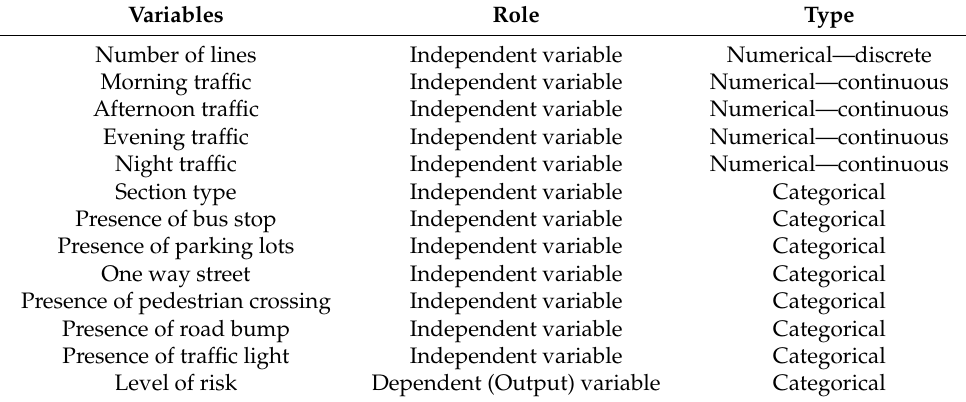
Table 3. List of variables used on the model: Role and type. Variables